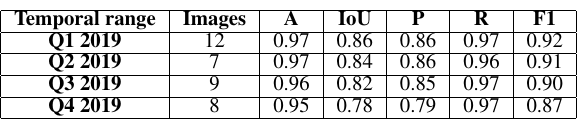
Table 3. Metrics of the AWEI approach with a time range of three months (Landsat-8).